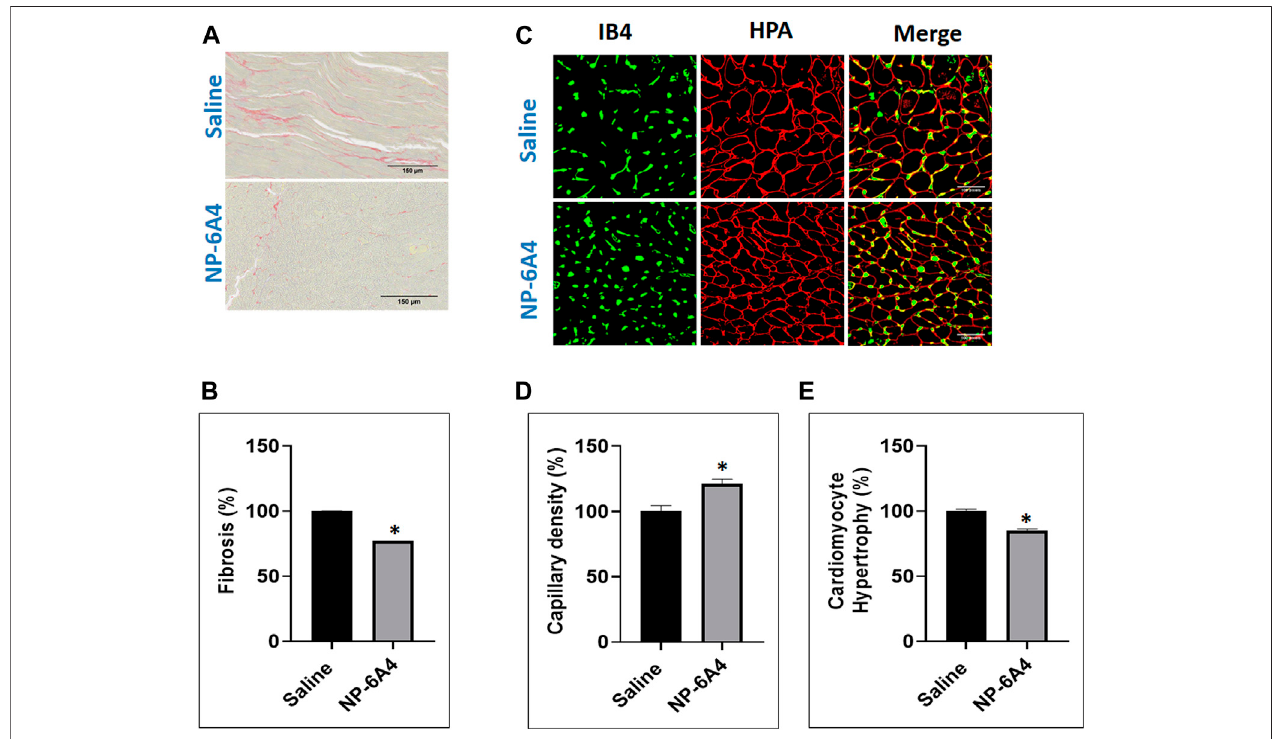
FIGURE 3 | NP-6A4 treatment attenuated cardiac fi brosis, hypertrophy and loss of cardiac microvascular density in ZO rats with untreated diabetes and obesity. (A) RepresentativeimagesofPSRstainedheartsectionsofZOratstreatedwithsalineorNP-6A4takenat × 20magni fi cation(scalebars (cid:1) 150 µm). (B) Graphshowsthe cumulative data for normalized fi brotic square area ( n (cid:1) 6 animals per group; 10 images per animal; 60 images per group). (C) Representative images of heart sections co-stained with HPA-Alexa Fluor (red) to visualize cardiomyocyte membrane IB4-Alexa Fluor 594 (green) to visualize capillaries ( × 40 magni fi cation; scale bars (cid:1) 100 µm). (D and E) Graphs show cumulative data for cardiomyocyte size and the number of capillaries per square area. n (cid:1) 6 animals per group; 10 images per animal; and 65 cells per animal from multiple